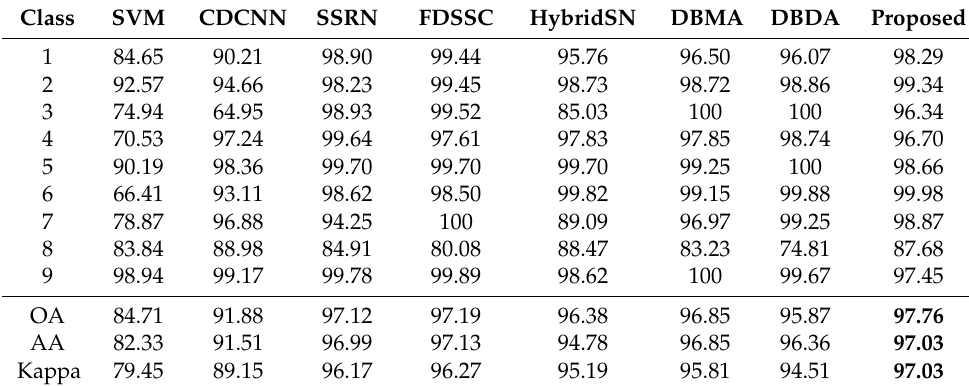
Table 9. The classification accuracy of different methods for the PU